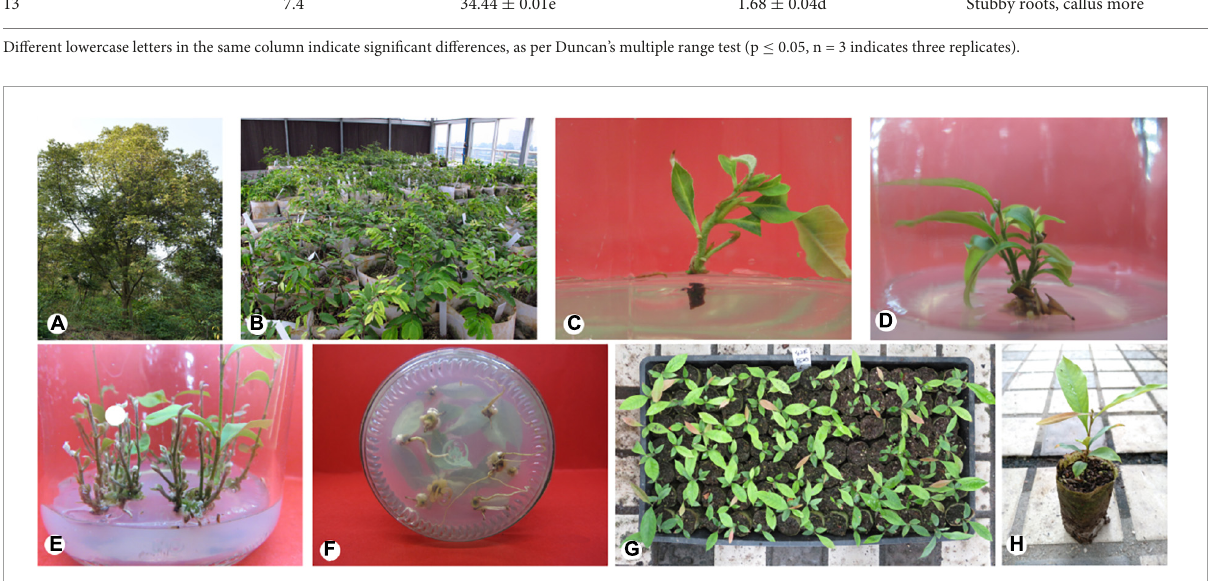
on HZ medium were robust and green in color and elongated